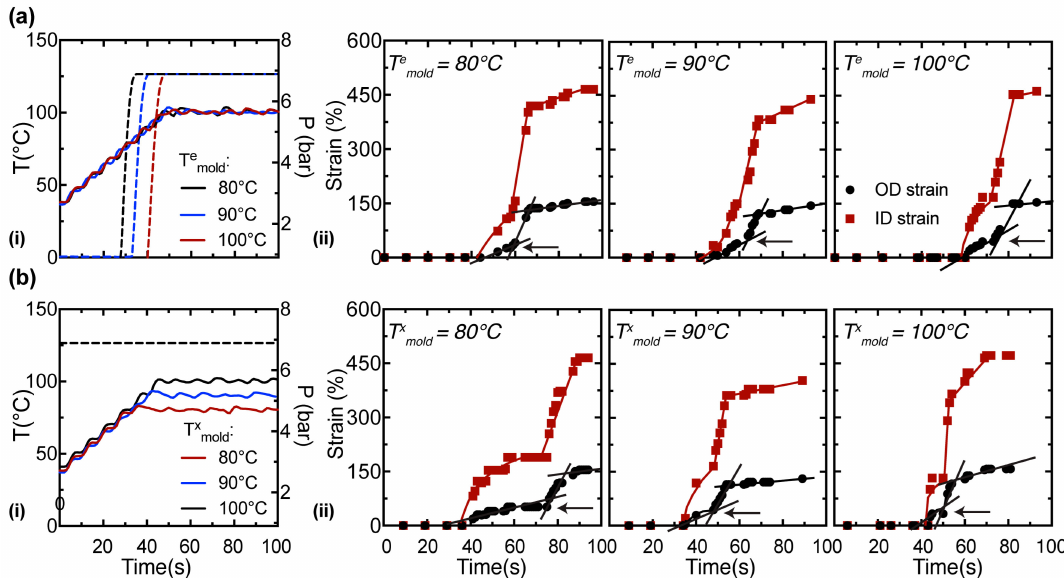
Figure 4. Plot of ( a , i ) temperature (solid lines) and pressure traces (dashed lines) for the first mode of operation; the pressure valve is triggered in ~5 s intervals to achieve expansion at T e mold = 80, 90 and 100 ◦ C. The corresponding strain fields are presented in ( a , ii ). Plot of ( b , i ) temperature (solid lines) and pressure traces (dashed lines) for the second mode of operation; tubes expanded at T x mold = 80, 90 and 100 ◦ C are pressurized to 6.87 bar prior to heating. The corresponding strain fields are presented in ( b , ii ). The strain at the outer diameter (OD, black circles in a , b , ii ) of the preform is determined from video recordings (error in strain ~5%) and the strain at the inner diameter (ID, red squares in a , b , ii ) is calculated from the OD strain assuming incompressibility (the difference in density between amorphous and crystalline PLLA is ~3% [28]). The slope of the straight black lines provides an estimate of the strain rate at the OD surface; the black arrows mark the inflection point when the strain rate abruptly increases. The error in synchronization between the video recordings and the synchrotron data (temperature, pressure and X-ray patterns) is ~5